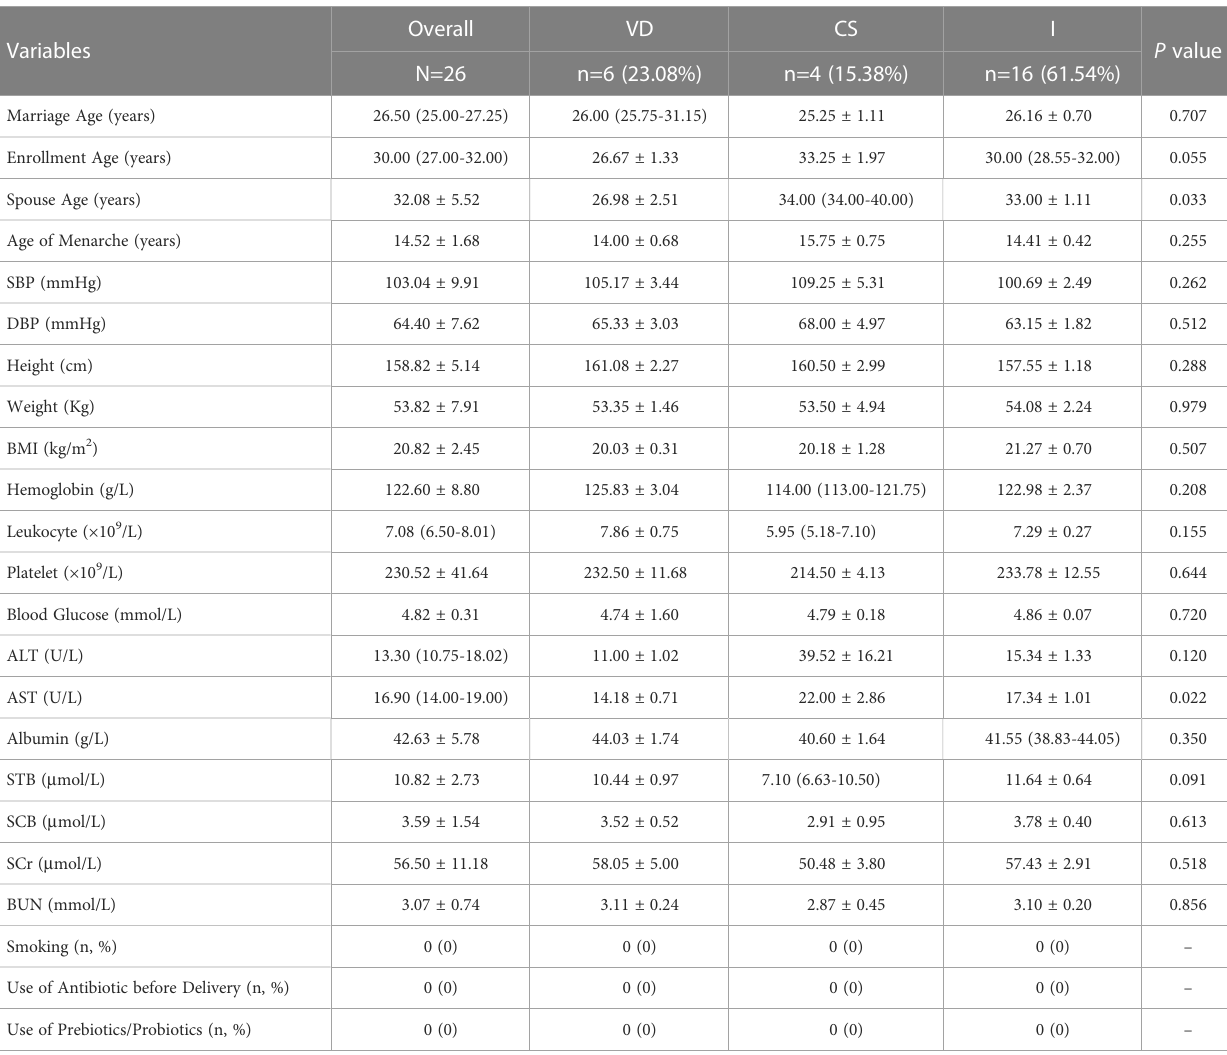
TABLE 1 Maternal Clinical Information at Baseline.